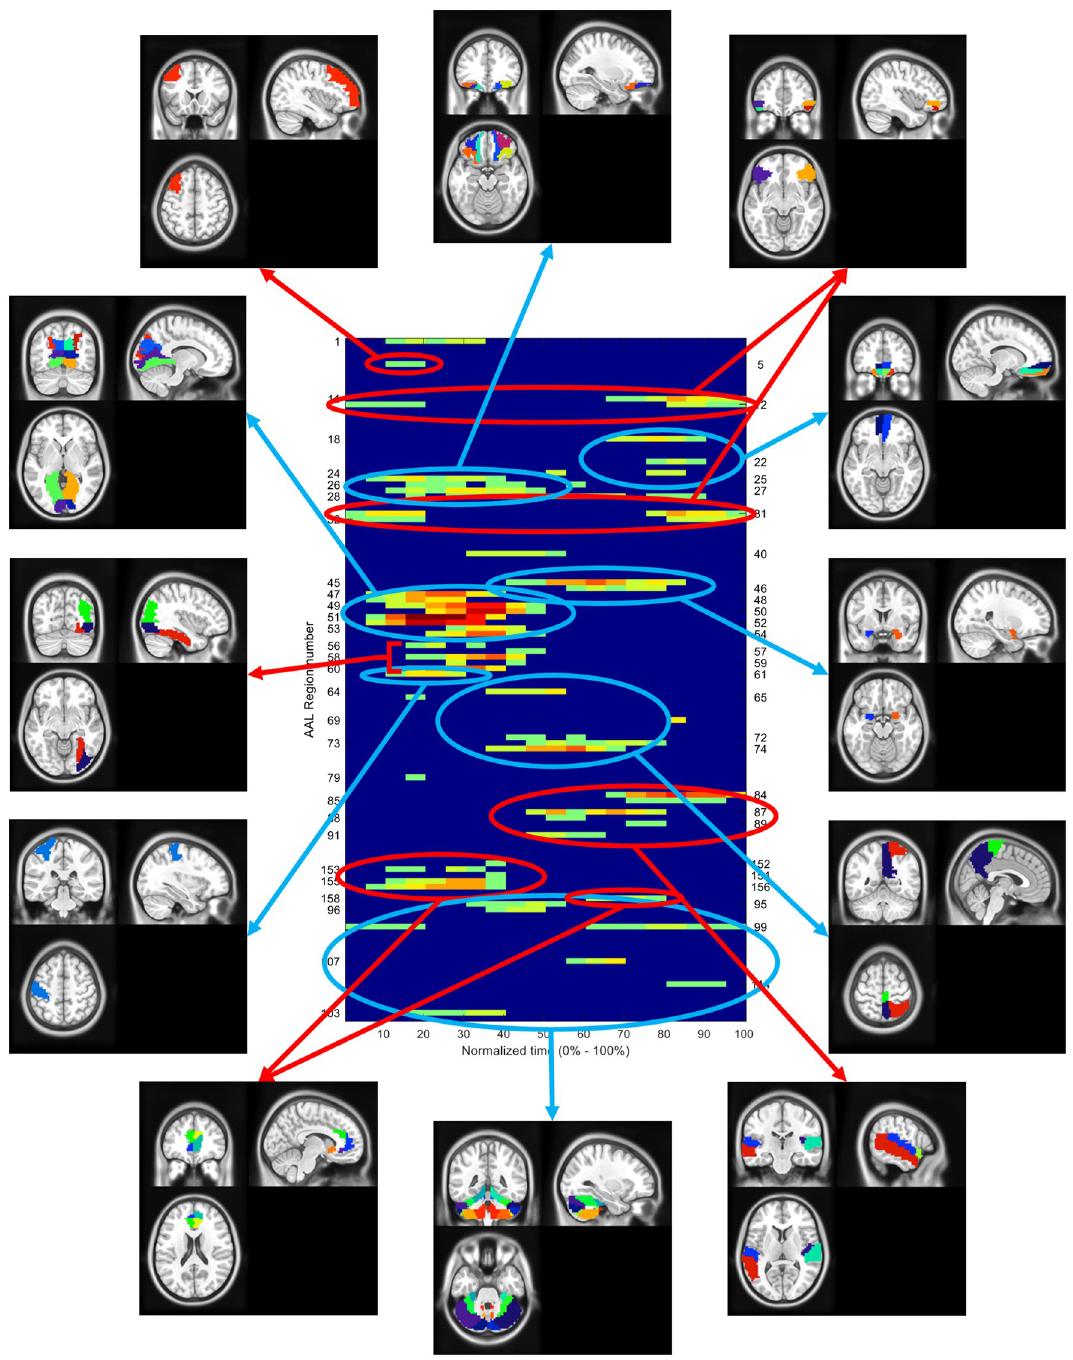
Fig 8. Brain regions corresponding to significant ROIs in the spatiotemporal plots shown in Fig